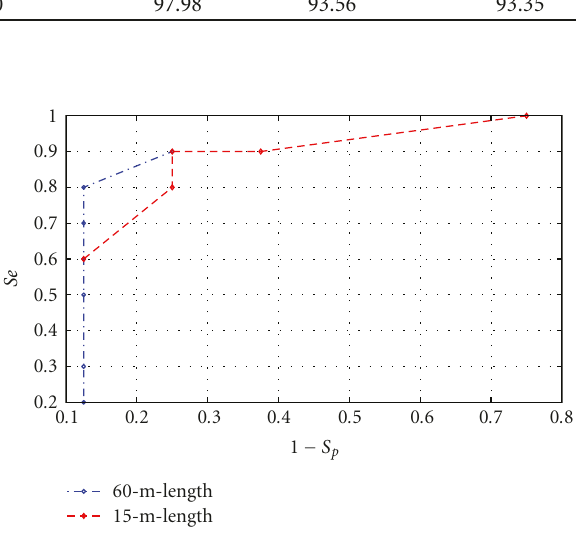
Figure 7: Performed ROC curves on dependence on both consid- ered fragment lengths.